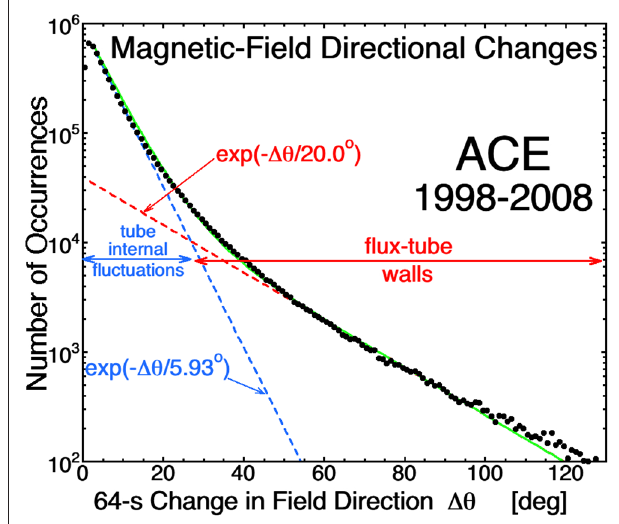
FIGURE 1 | The 64-s change in the solar-wind magnetic-field direction is binned for 11 years of measurements at 1AU by the ACE Magnetic Fields Experiment (Smith et al., 1998). The sum of the two exponential fit functions appears in green.